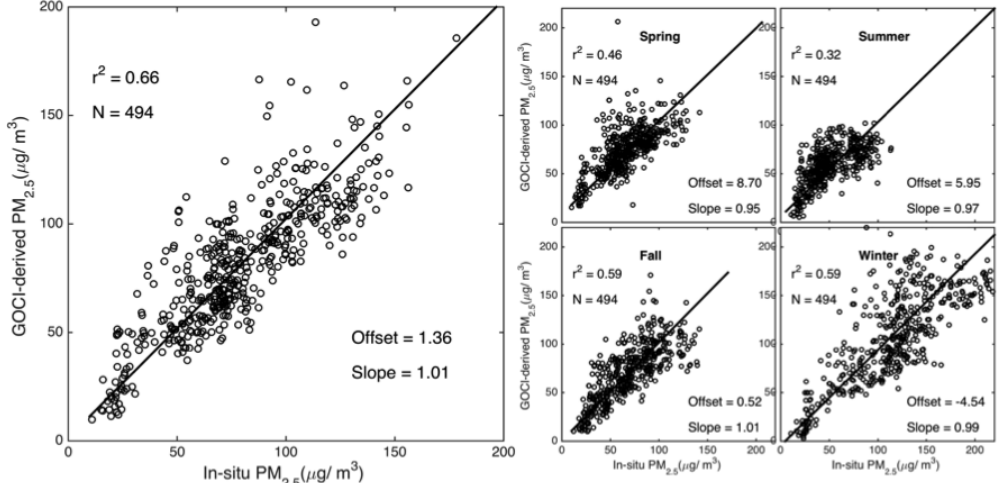
Figure 4. Scatterplots of the annual mean (left) and seasonal mean (right) GOCI-derived PM 2 . 5 for 2013 against PM 2 . 5 from 494 ground monitors over the GOCI domain in eastern China.